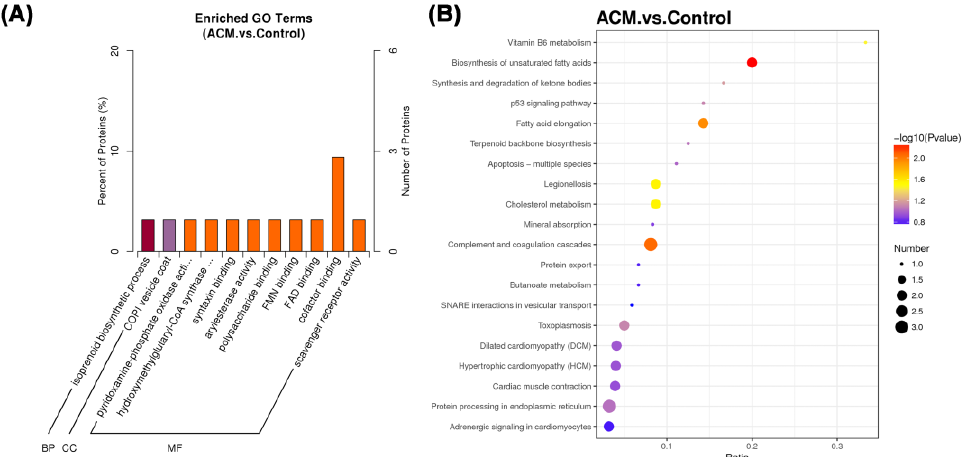
Figure 4. ( A ) Functional enrichment of GO annotation for DEPs. BP: biological process, CC: cellular component, and MF: molecular function. ( B ) The KEGG pathway enrichment analysis of different groups between the control group and the ACM group. The ratio of the number of differential proteins to the total number of proteins identified is the abscissa. From blue to red dots, it means that the adjusted p value is increasing from large to small, and the degree of enrichment is becoming more and more significant. The size of the dots represents the number of genes enriched in this pathway. Table 4. The major KEGG pathways and related DEPs.